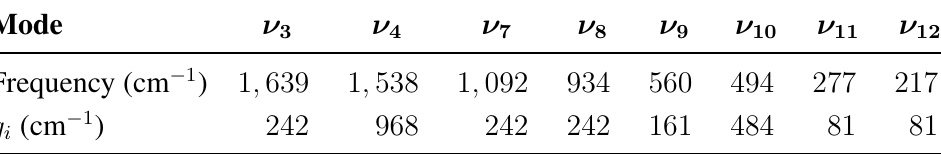
Table 4. The emv-coupling constants for a Pedron et al.